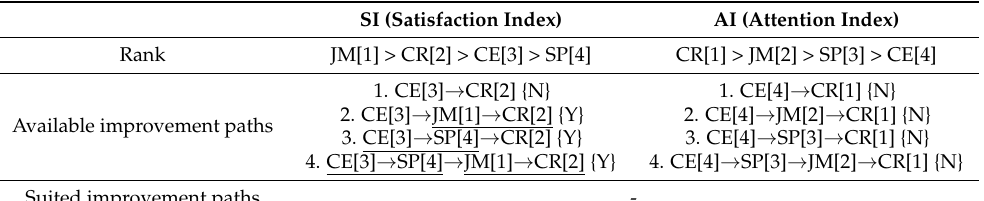
Table 5. The suited improvement paths of competence development of SDM tasks.